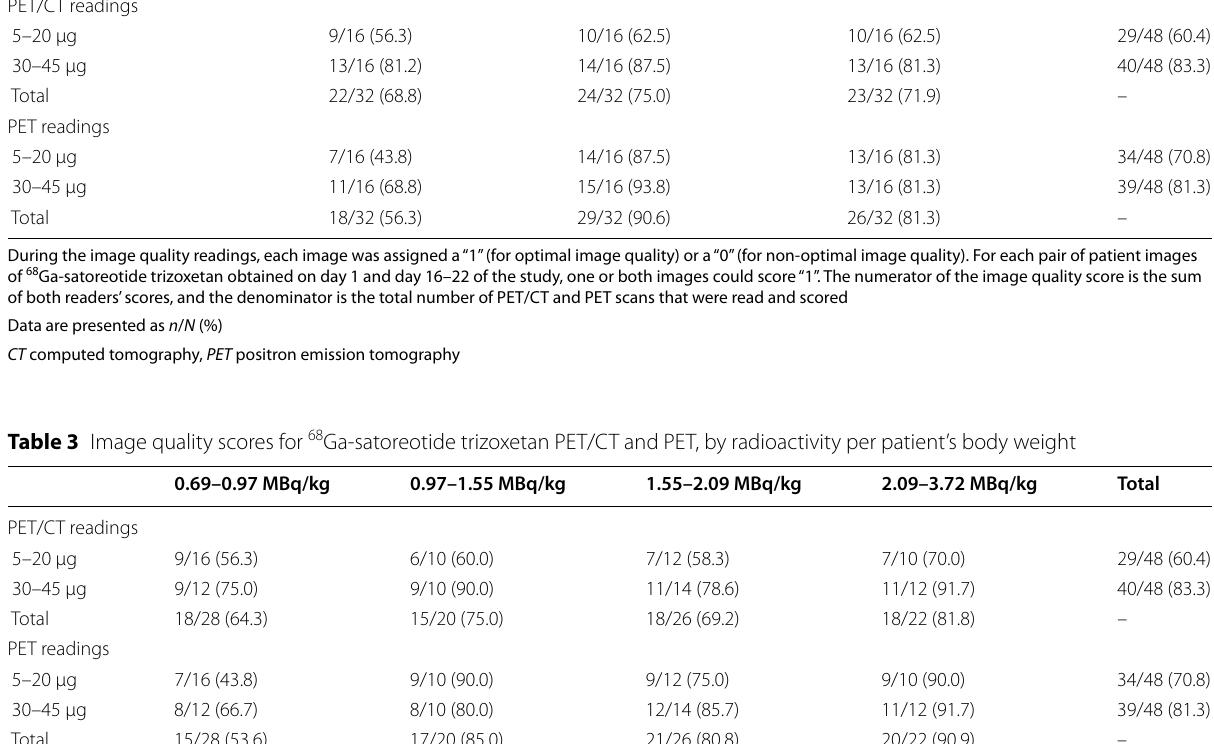
Table 2 Image quality scores for 68 Ga-satoreotide trizoxetan PET/CT and PET, by peptide mass and radioactivity range Peptide mass range